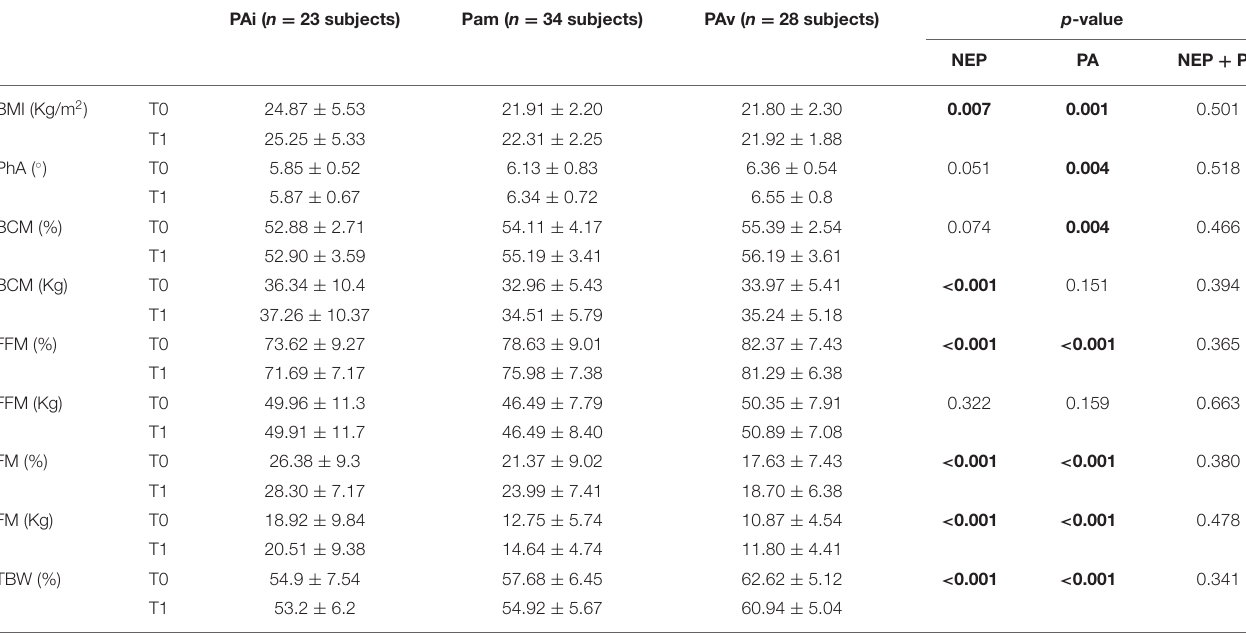
TABLE 1 | Anthropometric characteristics and body composition parameters of participants according to the three physical activity (PA) groups at baseline (T0) and after 6 months